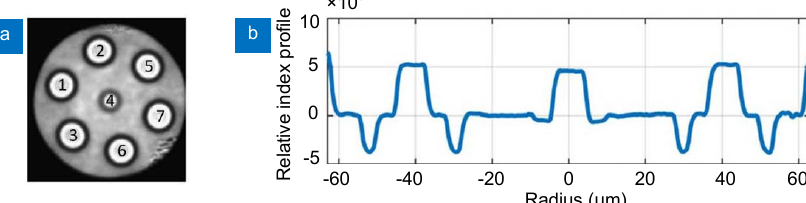
Fig. 12 | ( a ) Cross-sectional view of the heterogeneous MCF, whose outer six cores are made from the same preform but the central core is made from another preform. ( b ) Relative index profile of the heterogeneous MCF. Figure reproduced from ref. 56 , Optical Society of